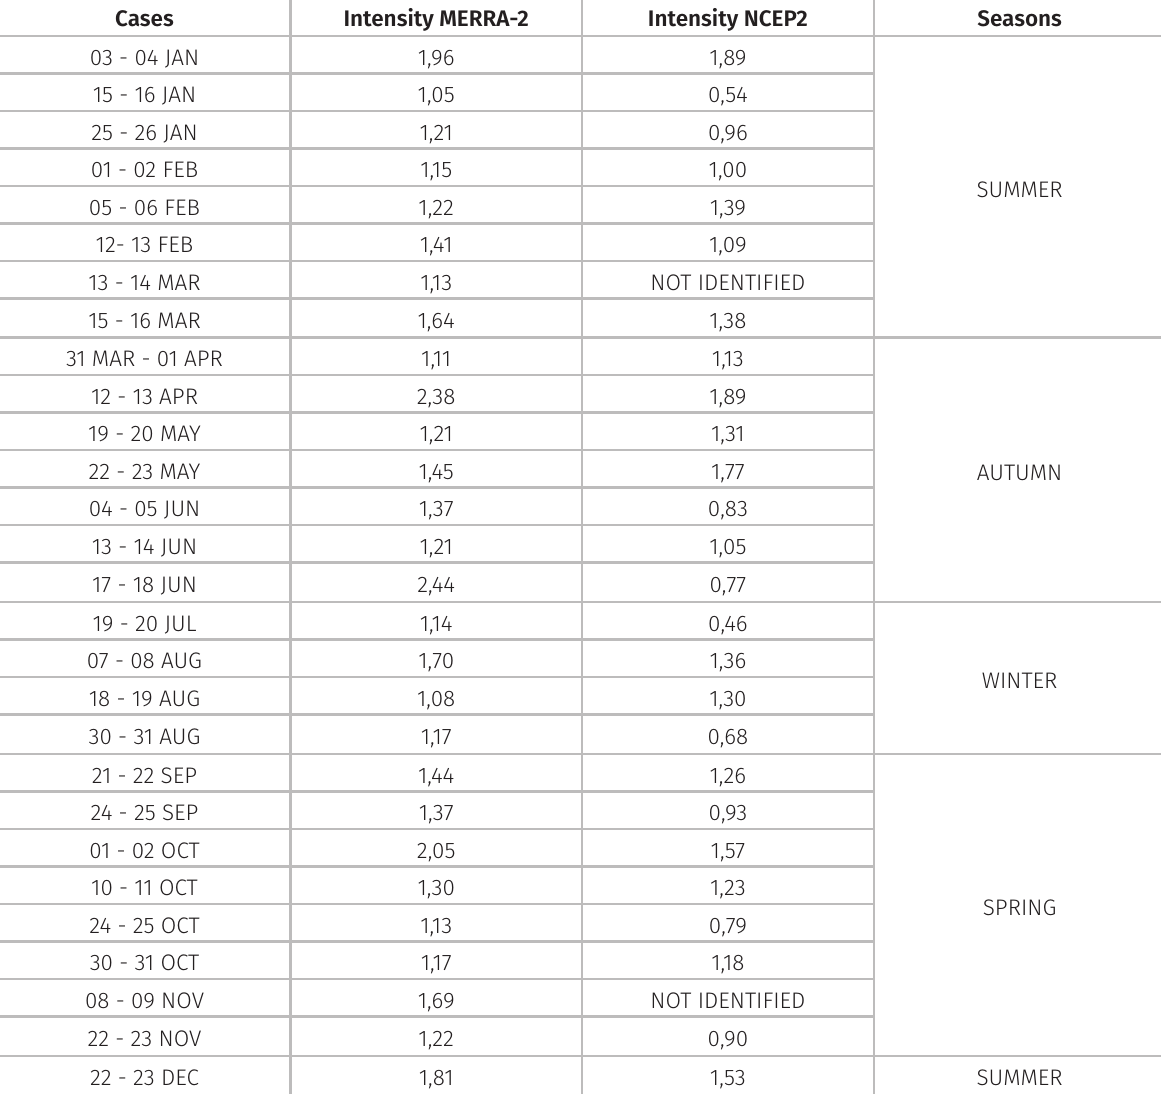
Table I. Intensity, in Bergeron, of the cases for both reanalyses and seasonal distribution in 2014.